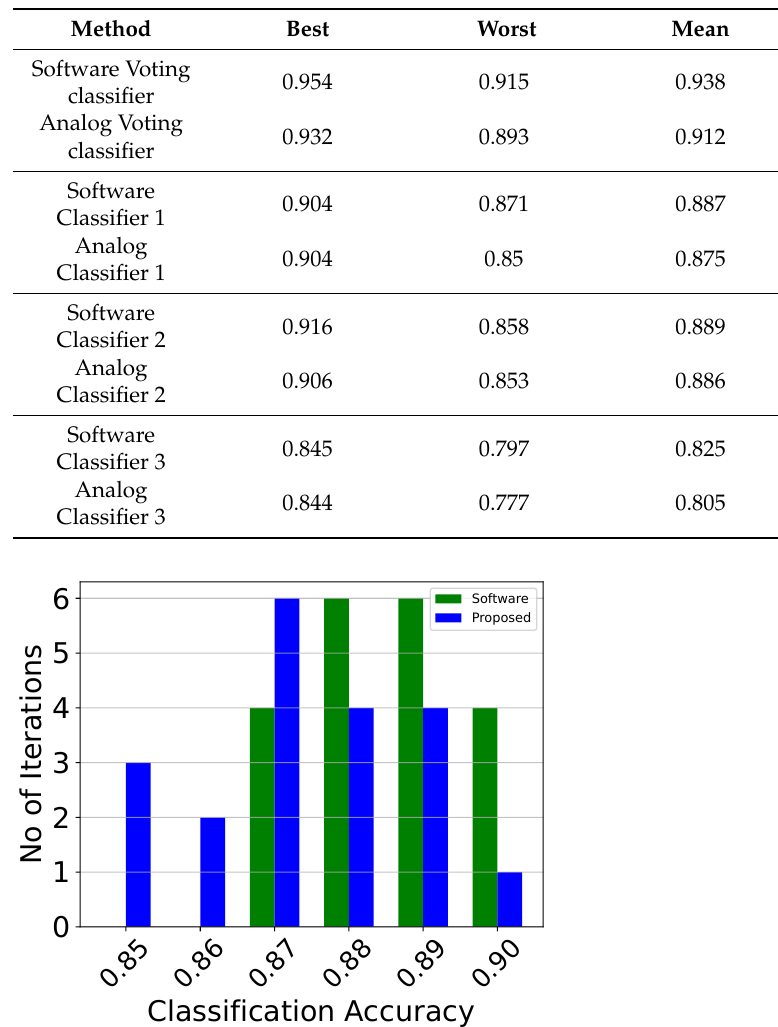
Table 2. Classification accuracies (over 20 iterations).